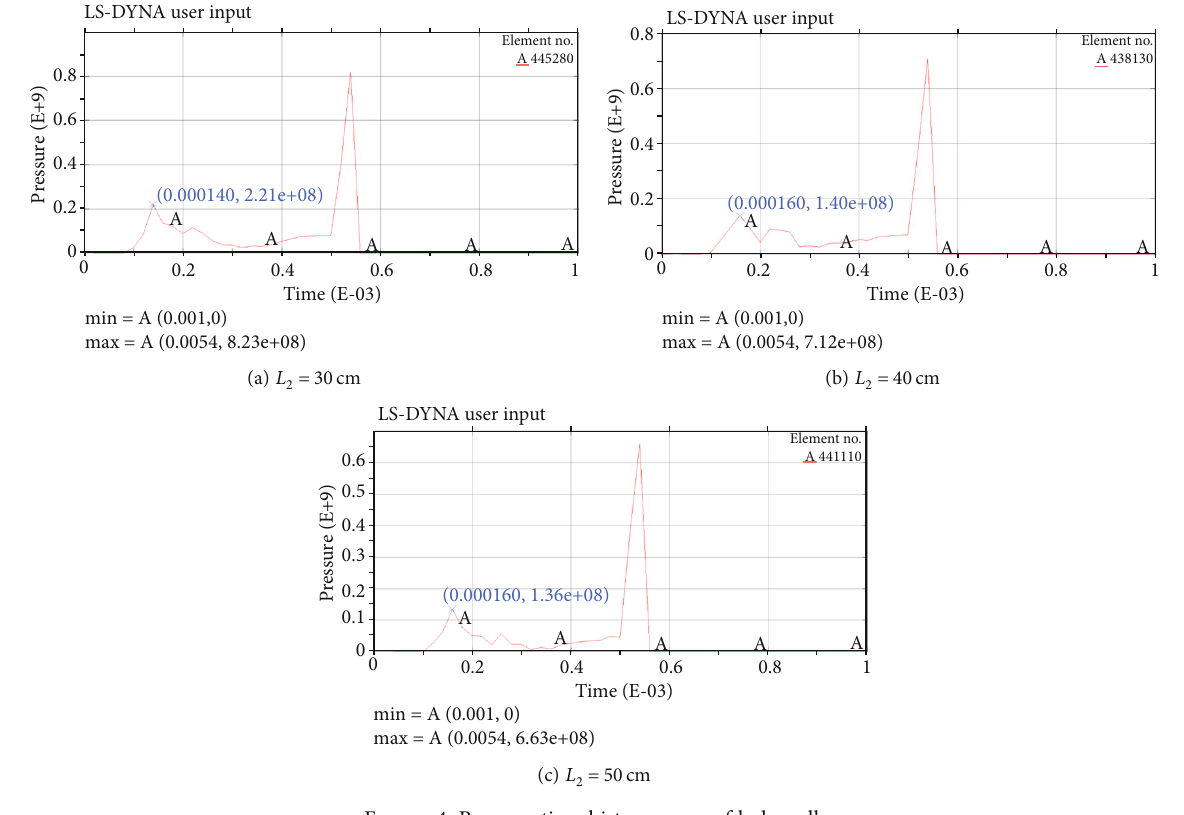
Figure 4: Pressure time history curve of hole wall. Table 8: Rock failure range at the distance between the third blast hole and the empty